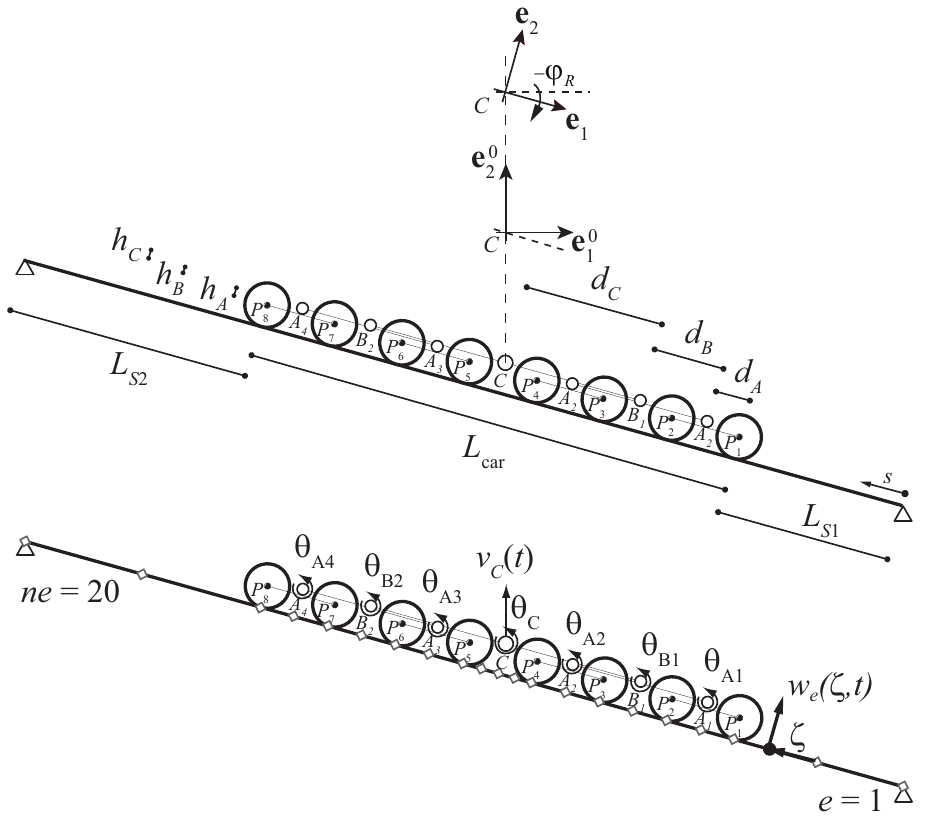
Figure 1. ( Top ) Geometric characteristics of the roller battery system in compression towers. ( Bottom ) Degrees-of-freedom and FE discretization (i.e., diamonds